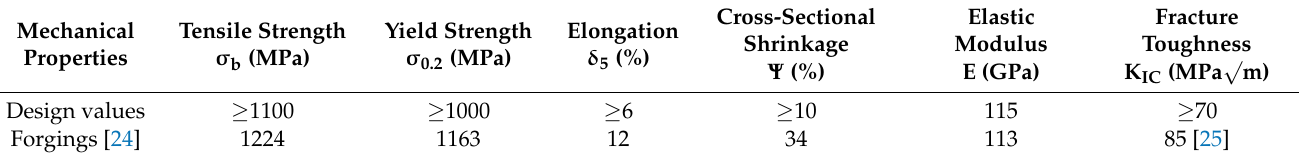
Table 1. The mechanical properties of titanium alloy TC21.